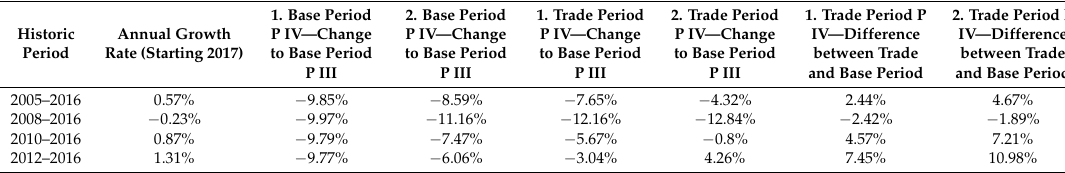
Table 2. Production trends in the